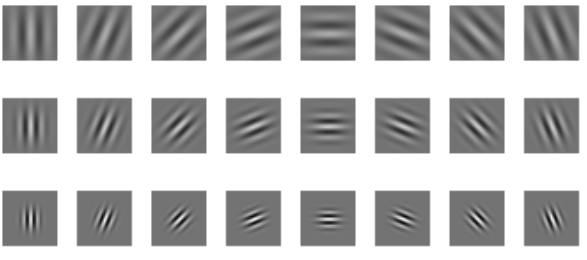
Figure 2: Gabor filter bank for 3 scales and 8